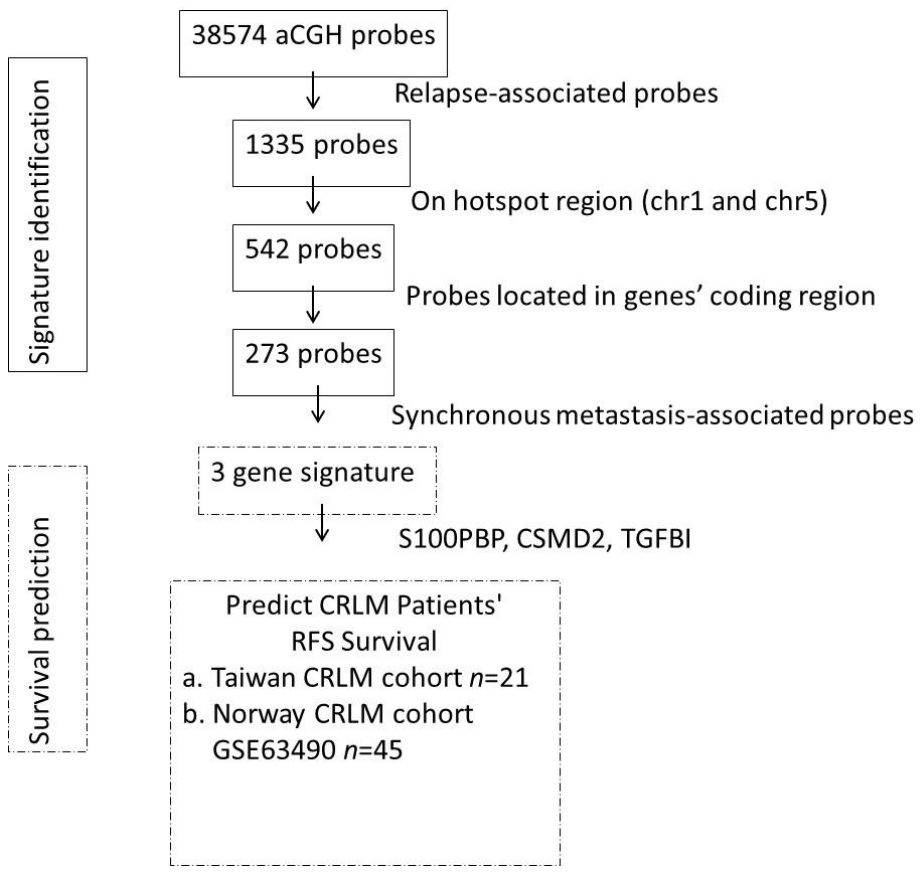
Figure 2. Flowchart of gene selection and analysis procedures.